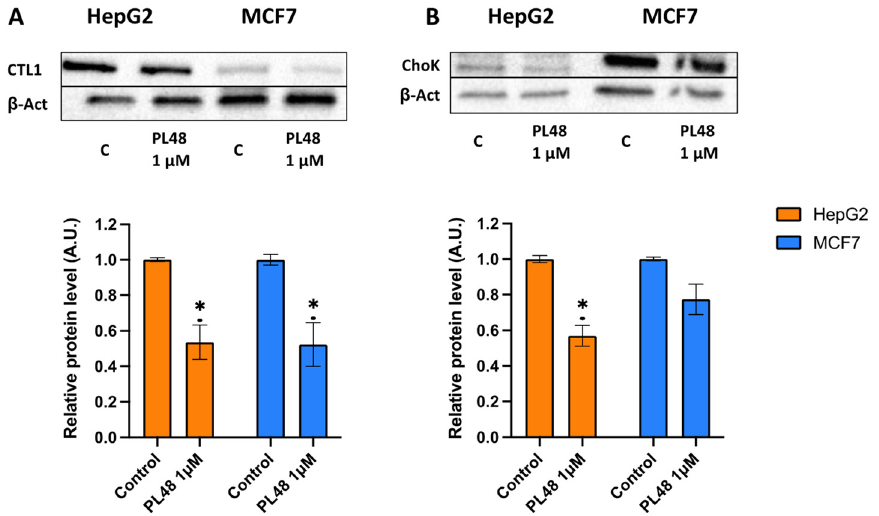
Figure 8. Effect of PL48 on CTL1 and ChoK protein levels in HepG2 and MCF7 cells. Cells were incubated without PL48 (control) or with 1 µM PL48 for 48 h. ( A ) Western blots show representative results of experiments repeated three times. ( B ) Protein levels in the samples were normalised to their respective β -actin levels and expressed as x-fold change compared with the corresponding control ratio (1.0). Data represent the mean ± SEM of three independent experiments. * p < 0.05.